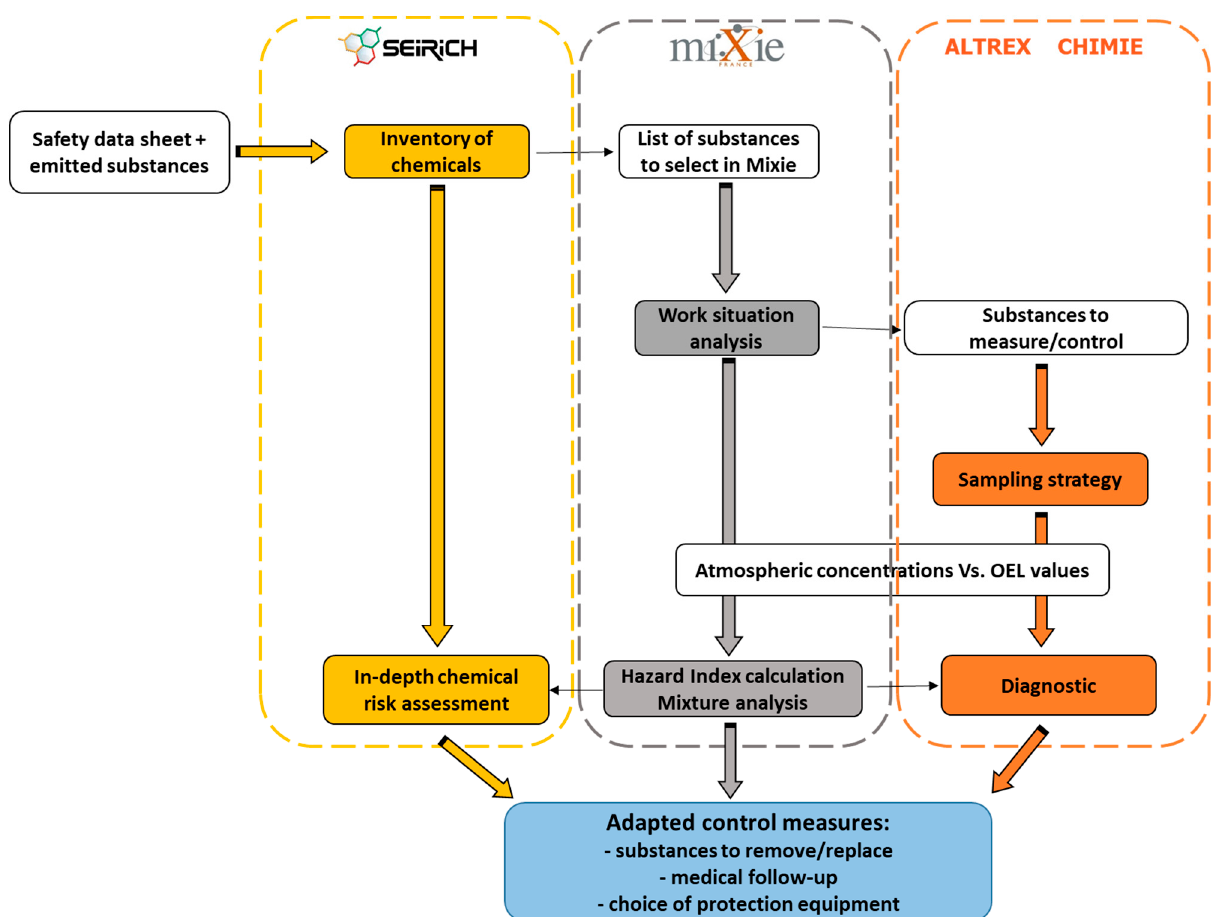
Figure 5. Coordinated use of MiXie, the Seirich chemical inventory, and the Altrex sampling strategy tools developed at INRS for risk assessment of multiple exposures. White boxes show input data and coloured boxes show the output generated by each tool.